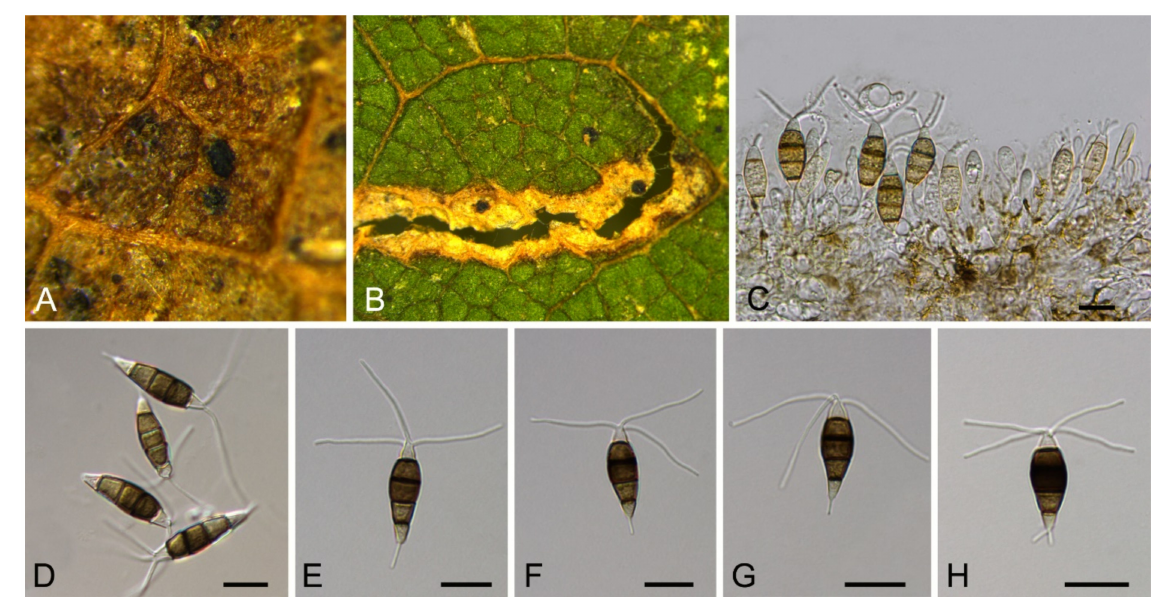
Figure 14. Neopestalotiopsis asiatica (BJFC-S1789). ( A , B ) Conidiomata on the diseased leaves of Castanea mollissima ; ( C ) Coni- diogenous cells giving rise to conidia; ( D – H ) Conidia. Scale bars: ( C – H ) = 10 µ